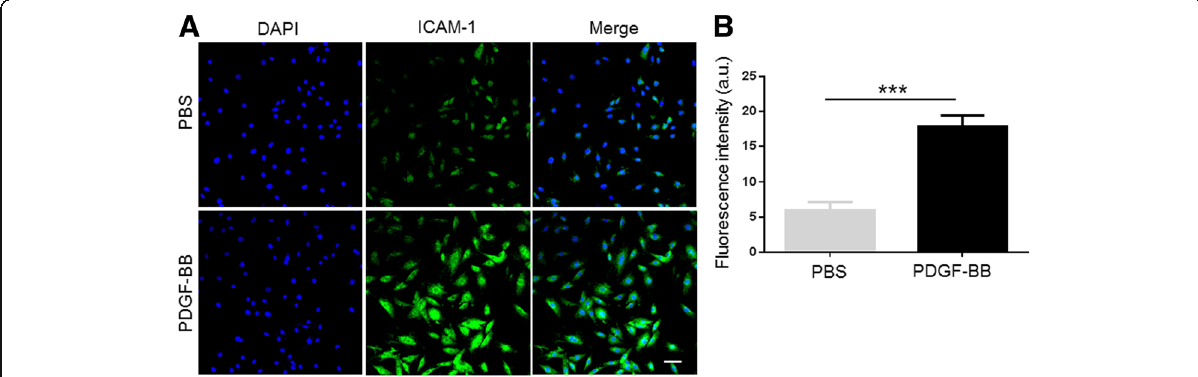
Fig. 4 a Immunofluorescence images of ICAM-1 expression in MOVAS cells following treatment with platelet-derived growth factor (PDGF)-BB (20 μ g/mL) for 24 h. Left column DAPI channel showing blue fluorescence, middle column FITC channel showing green fluorescence from the liposomes, right column DAPI and FITC channels merged. Bars = 50 μ m. b Mean FITC fluorescence intensity obtained from images in a . Values are expressed as the means ± SD ( n = 3). *** P <